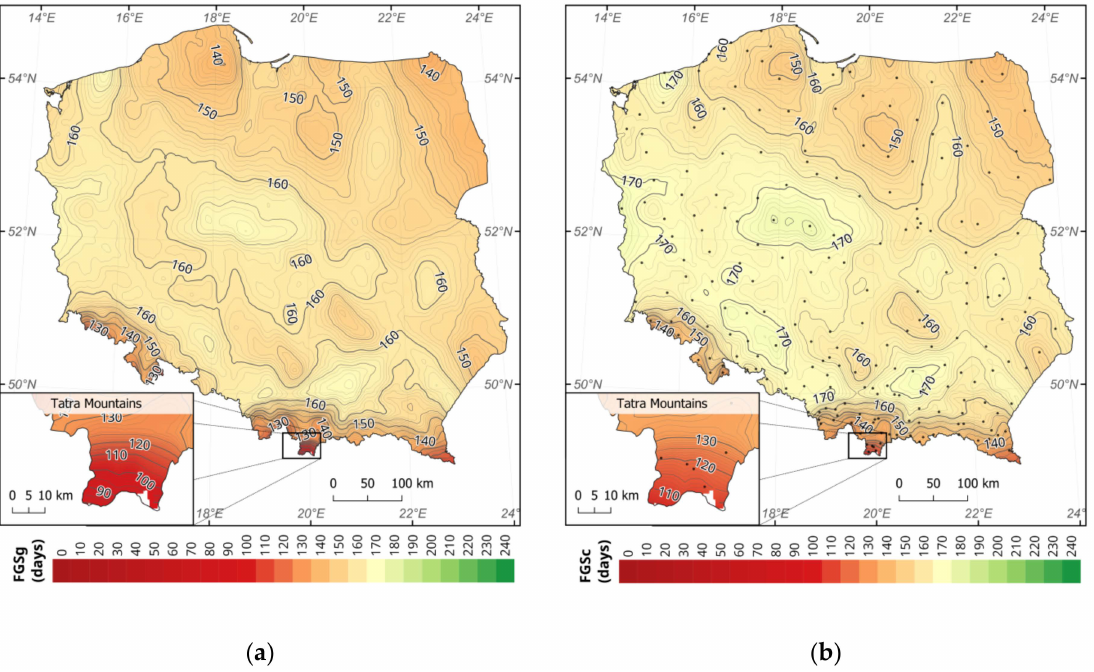
Figure 5. FGSg in Poland for 1970–2000 based on data from WorldClim 2.1 ( a ) and FGSc, obtained after applying correction model based on a comparison with FGSr, determined from measurements from 245 meteorological stations (black dots) ( b ).